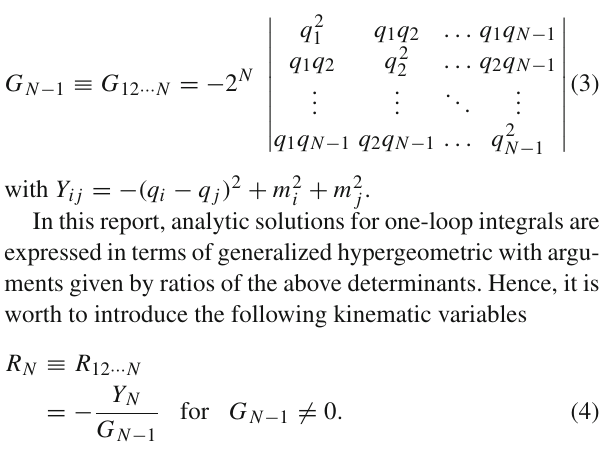
Fig. 1 Generic Feynman diagrams at one-loop with N external momenta